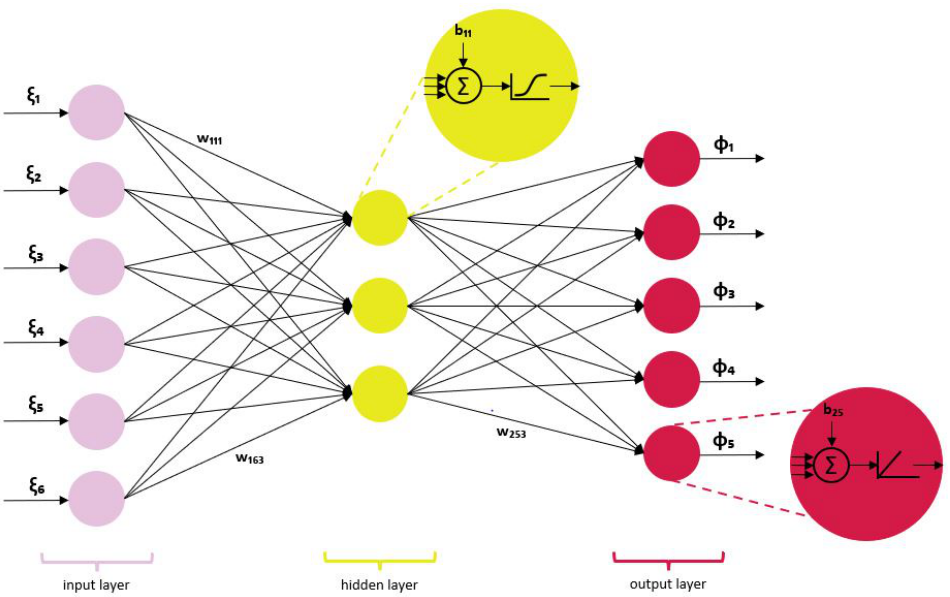
Figure 5. A multilayer perceptron with one hidden layer with 3 neurons; 6 input signals in the input layer, which are the concentrations of culture species; and 5 output signals in the output layer, which are the reaction rates of each bioreaction. The biases are denoted by b i and activation functions in the hidden layer are sigmoids while activation functions in the output layer are identity